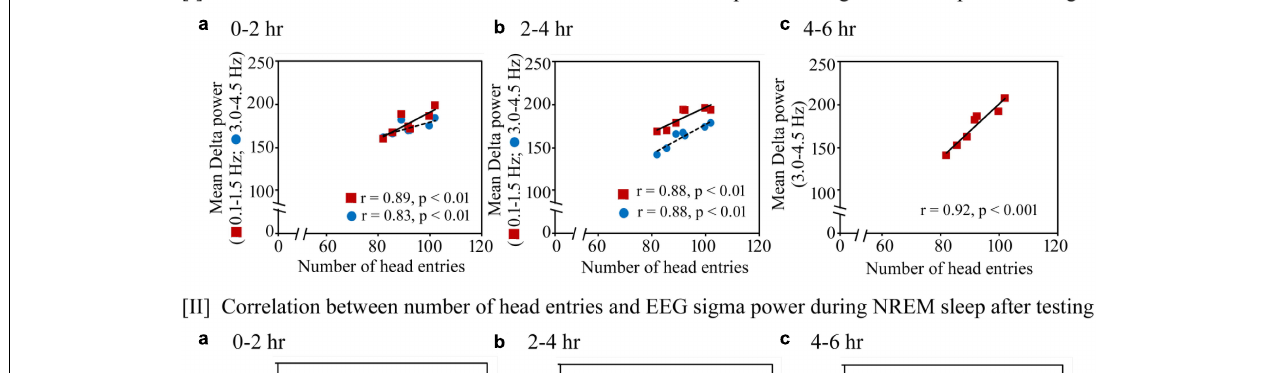
( r = 0.96; p < 0.001) and 4–6 h ( r = 0.82; p < 0.01) ( Figures 8II b,c ). The increased theta power (6–9 Hz) during REM sleep also ( r = 0.83; p < 0.01), 2–4 h ( r = 0.81; p < 0.01) and 4–6 h ( r = 0.86; p < 0.01) ( Figures 8III a–c